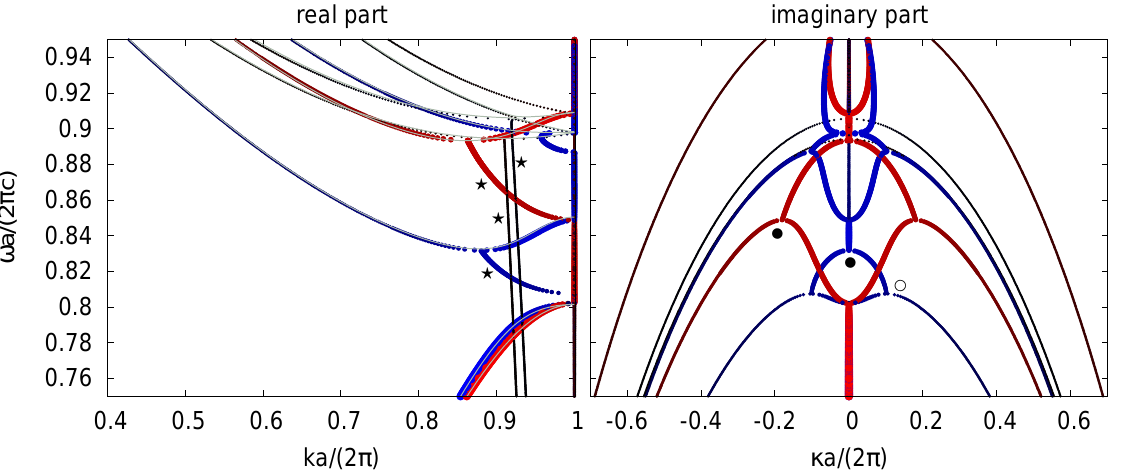
Figure 10. CBS diagram along the r 100 s direction of a single gyroid PhC calculated with N “ 2007 plane waves. The solid lines that are hardly perceivable and shown on the left represent the results of an MPB [17] calculation for N (and otherwise the same parameters), which serves as reference for the purely propagating Bloch